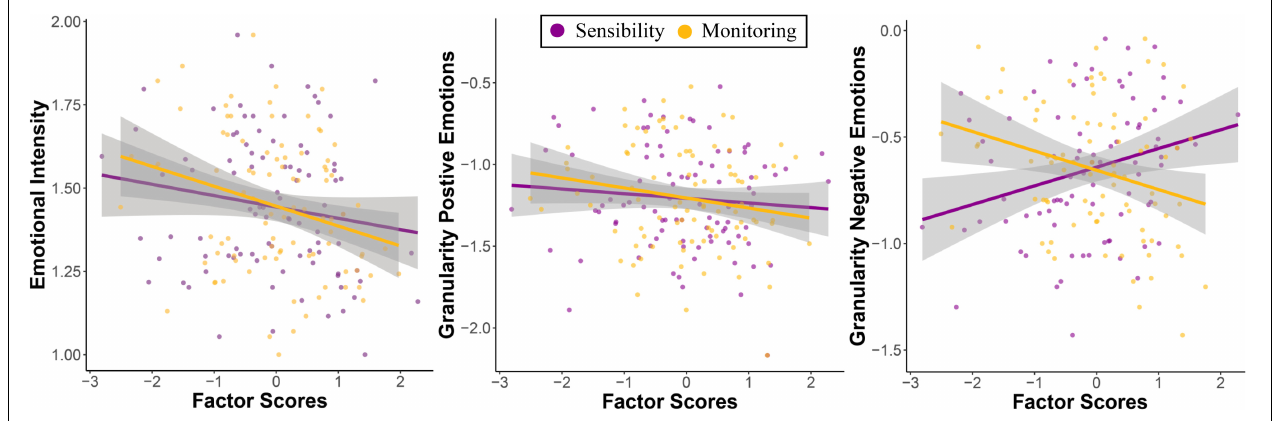
FIGURE 2 | Association between emotional intensity and granularity scores and Sensibility and Monitoring factor scores in the DRM.